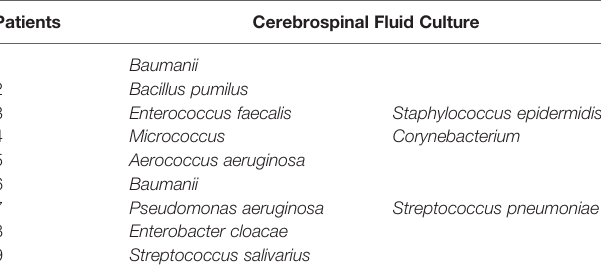
TABLE 3 | The presence of culture in the